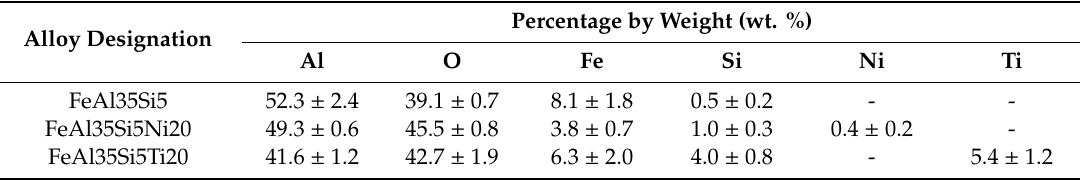
Table 5. Chemical composition of the oxide layers